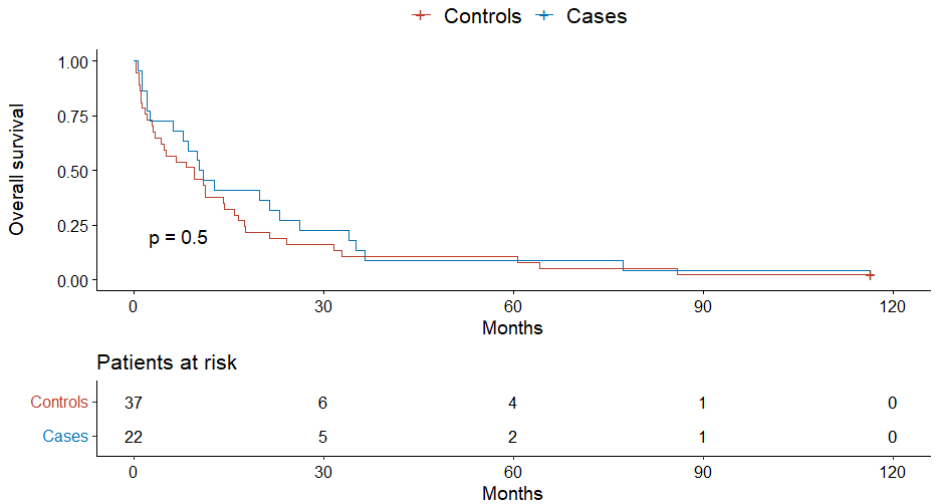
Figure 3. The overall survival of cases and controls with no comorbidities.